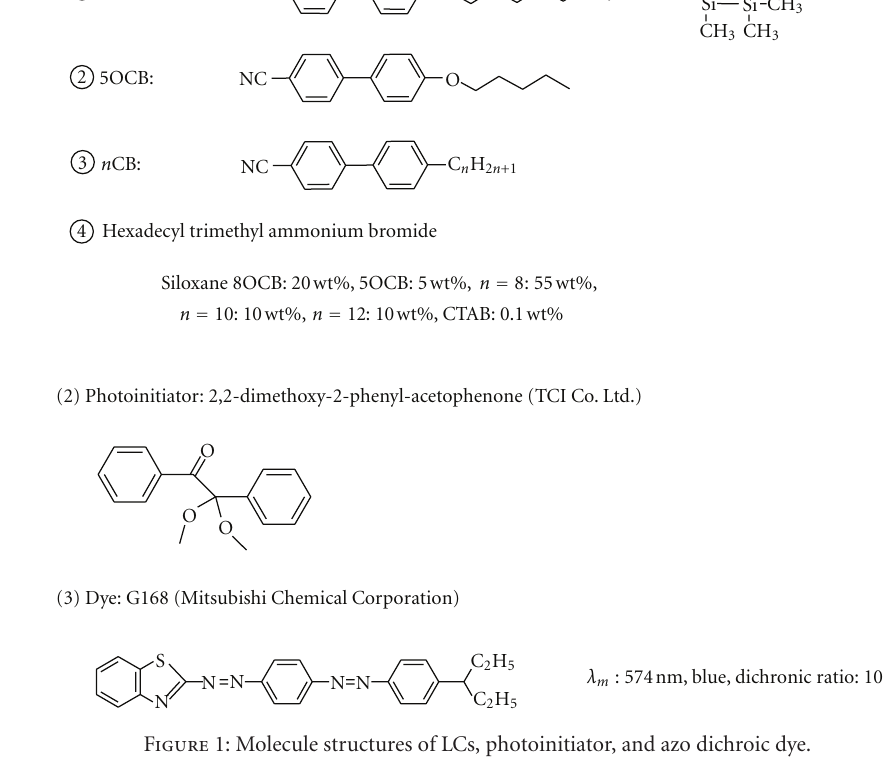
Figure 1: Molecule structures of LCs, photoinitiator, and azo dichroic